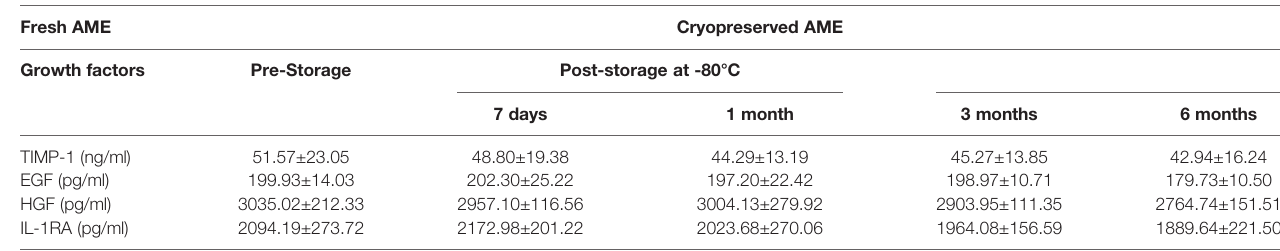
TABLE 1 | Concentrations of growth factors in fresh and cryopreserved